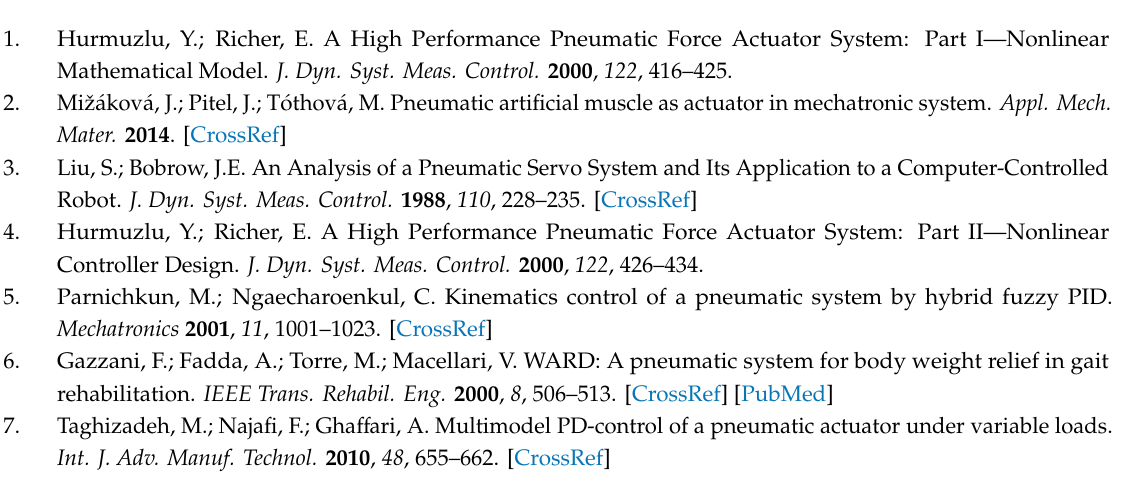
Table 3. Performances of comparative experiments.